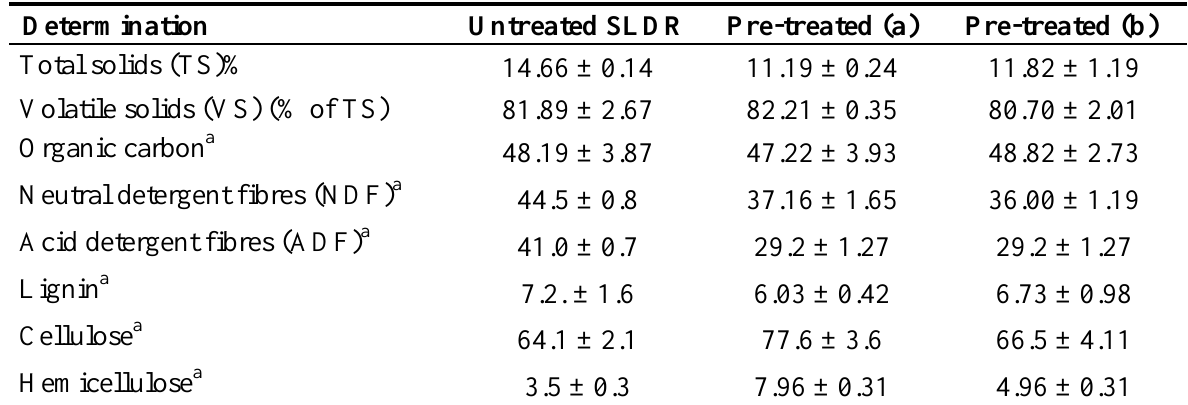
Table 1. Composition of SLDR before (untreated) and after two stage fungal pre-treatment (mean ± SD) n =